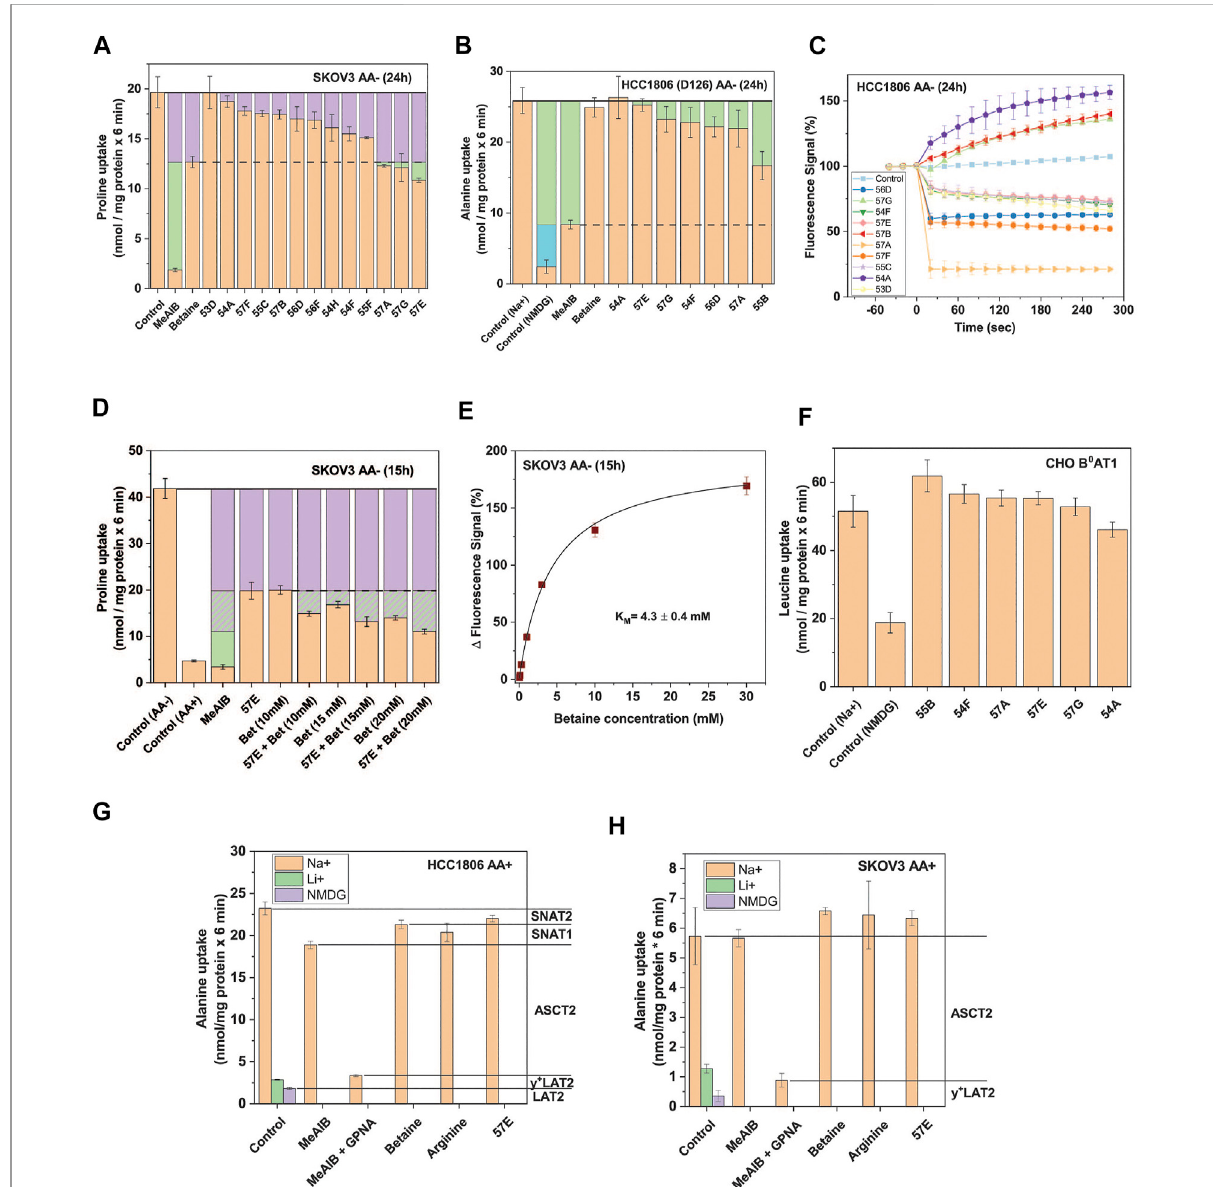
FIGURE 4 SelectiveSNAT2inhibitorsidenti fi edbyHTS. (A) Thirteenhitcompoundswereassayedataconcentrationof30 µMfortheireffectontheuptake of 100 µM proline in SKOV3 cells pre-incubated in starvation medium for 24 h to induce SNAT2 expression. MeAIB (10 mM) was included to inhibit SNAT1/2, and betaine (10 mM) to selectively inhibit SNAT2. The dashed line indicates the maximum functional contribution of SNAT2 (rates below this threshold signify partial or total inhibition of SNAT1). Green boxes indicate SNAT1 activity. Data are shown as the mean ± STD (n = 3) (B) Selected hit compounds were assayed at 50 µM for their effects on [ 14 C]proline (at 100 µM) uptake in HCC1806 clone D126 (SNAT2 ko) starved of amino acids for 24 h. MeAIB (10 mM) was included to inhibit SNAT1, and betaine (10 mM) to con fi rm the absence of SNAT2 activity. Green boxes represent SNAT1 activity and the blue box represents transport activity unrelated to SNAT1/2. The rate from the background control (not shown), whereradiolabelledalanineorprolinewasincubatedinthepresenceof10 mMofitsunlabelledform,wassubtracted.Dataareshownasthemean± STD(n=3). (C) HCC1806cellswereaminoaciddepletedfor24 htoinduceSNAT1/2activity.Todeterminenon-speci fi ceffectsintheFMPassay,ten hit compounds were introduced to the cells pre-incubated in the FMP dye and mHBSS at t = 0s at a concentration of 30 µM. Upward de fl ection indicates depolarisation, downward de fl ection hyperpolarisation. The control consisted of introducing plain mHBSS to the wells. Data are shown as the mean ± STD (n = 3). (D) Compound 57E was assayed at 30 µM for its effect on the uptake of 100 µM proline by itself and when combined with increasing concentrations of betaine. SKOV3 cells were pre-incubated in starvation medium for 15 h to induce SNAT2 expression. MeAIB (10 mM) and non-starved (AA+) SKOV3 cells were included as controls to show the upregulation of SNAT1/2 following starvation. The purple boxes correspondtotheminimumactivityattributabletoSNAT2andthehashedpurplecorrespondstopotentialSNAT2activity.Thegreenboxesrepresent the activity of SNAT1. The rate from the background control, where radiolabelled proline was incubated in the presence of 10 mM of its unlabelled form, was subtracted. Data are shown as the mean ± STD (n = 3). (E) SKOV3 cells were pre-incubated in starvation medium for 15 h to induce